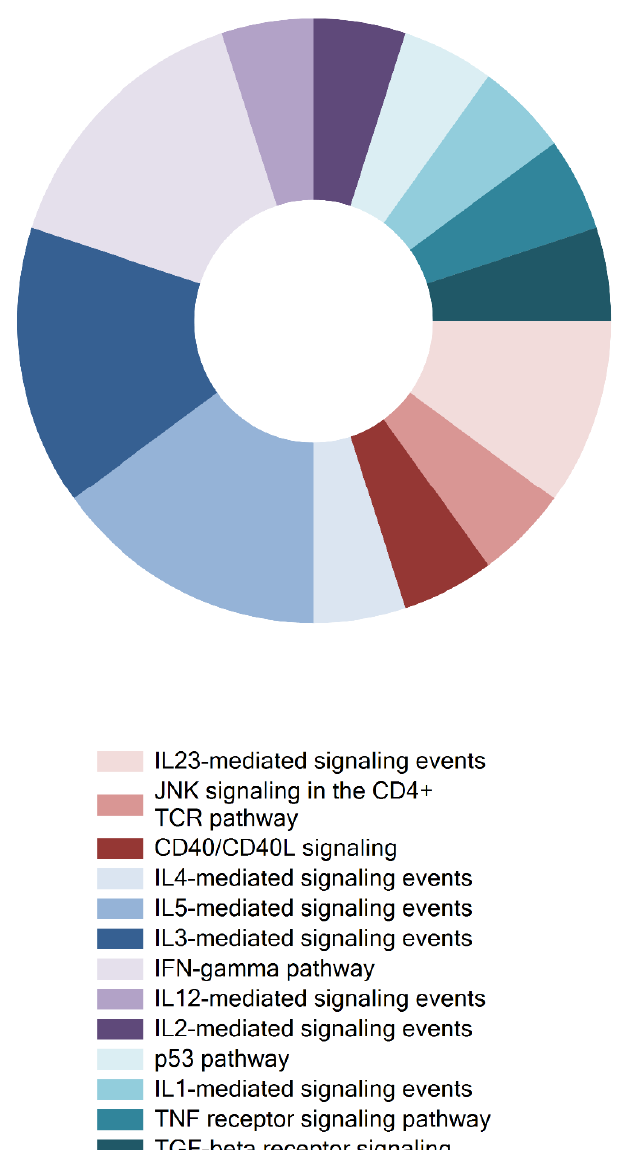
Figure 6. Elevated cytokine levels in saliva of radiated head and neck patients a ff ected pro-inflammatory and apoptotic cellular pathways. The FunRich analysis of cytokines that were significantly upregulated in the saliva samples from the patients revealed which cellular pathways were influenced by these elevated cytokines, and the fractions of total upregulated cytokines that were involved in a ff ecting these di ff erent cellular pathways. These included T cell JNK (20%), and CD40 / CD40L (20%) signalling, IL-1 (20%), IL-2 (20%), IL-3 (60%), IL-4 (20%), IL-5 (60%), IL-12 (20%), and IL-23 (40%) signalling, in addition to TNF (20%) and TGF- β (20%) receptor signalling, and finally the apoptotic p53 pathway (20%).